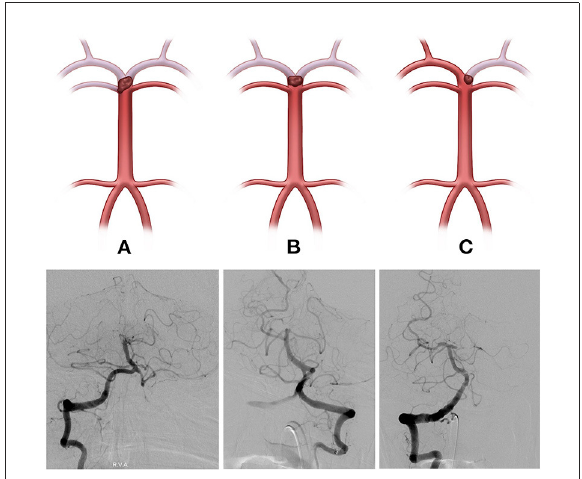
FIGURE1 The basilar top occlusion type was classified into three groups (Illustrations and angiographies). ( A , Type I) Bilateral posterior cerebral arteries (PCA), with one side of the superior cerebellar artery (SCA) not visible on catheter angiography, ( B , Type II) Bilateral PCA not visible with both SCA intact, and ( C , Type III) PCA occlusion on one side.